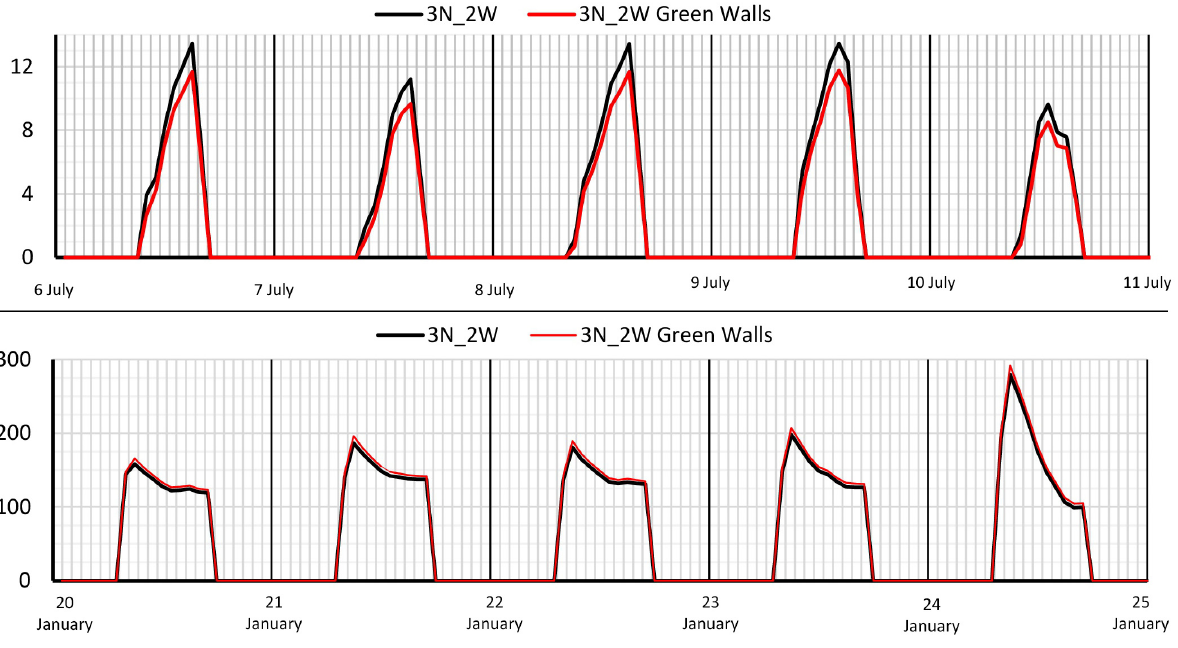
Figure 7. Trend of cooling and heating demand for summer and winter reference weeks, respec- tively.